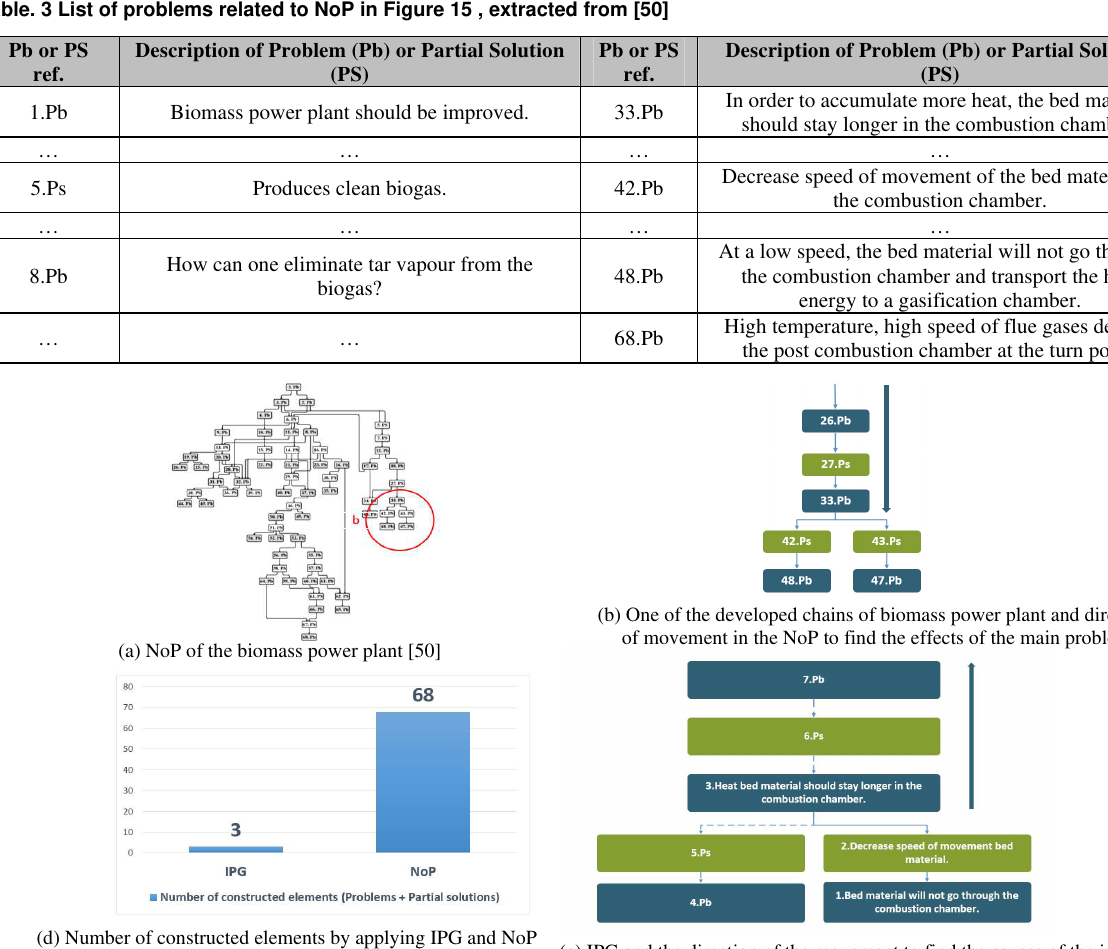
(c) IPG and the direction of the movement to find the causes of the initial problem